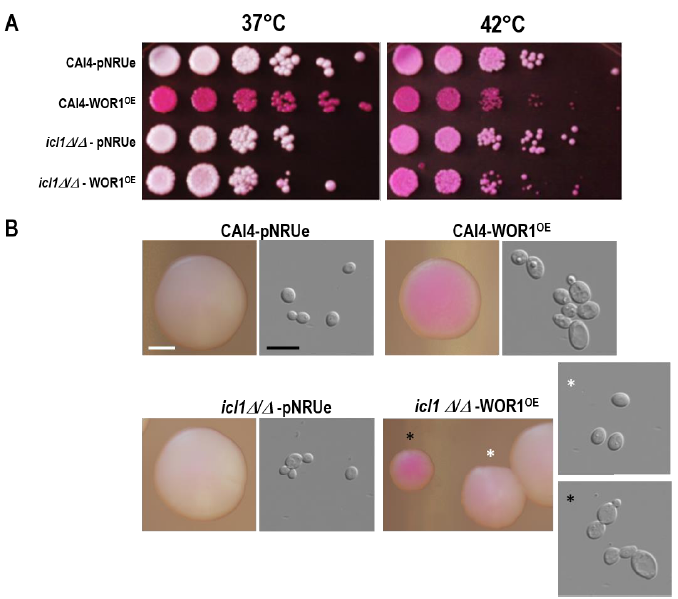
Figure 3. Effect of WOR1 overexpression on phloxine B+ cell formation in wt and icl1 Δ / Δ back- grounds. ( A ) Production of phloxine B + cells. Cells were grown for 18 – 20 h at 37 °C. Cells of CAI4- pNRUe, CAI4-WOR1 OE , icl1 Δ / Δ , and icl1 Δ / Δ -WOR1 OE strains were spotted onto YPD supplemented with 10 µg/mL of phloxine B and incubated at 37 °C for 48 h. ( B ) 200 CFUs were spread on the same media and incubated at 37 °C for 48 h. White scale bar stands for 0.5 mm; black scale bar stands for 10 µm. Photographs of individual colonies and their corresponding cells are shown and marked with either a white or black asterisk.